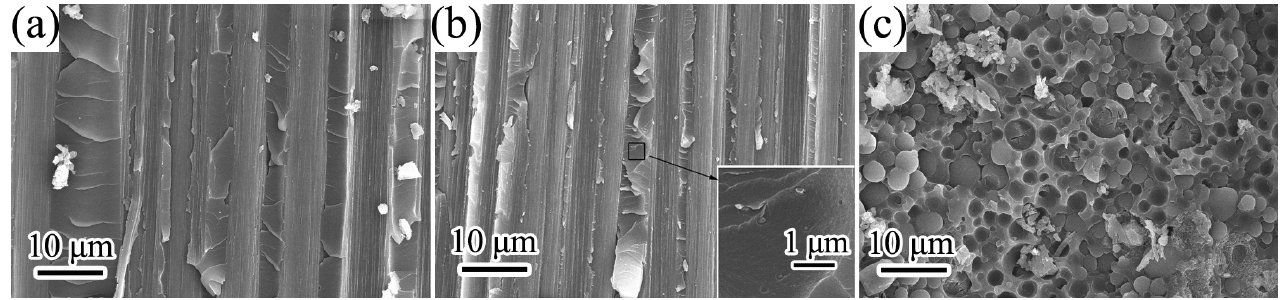
Figure 7. SEM images of the mode I fracture surfaces of ( a ) the control, ( b ) PS0-C, ( c ) PS100-C.